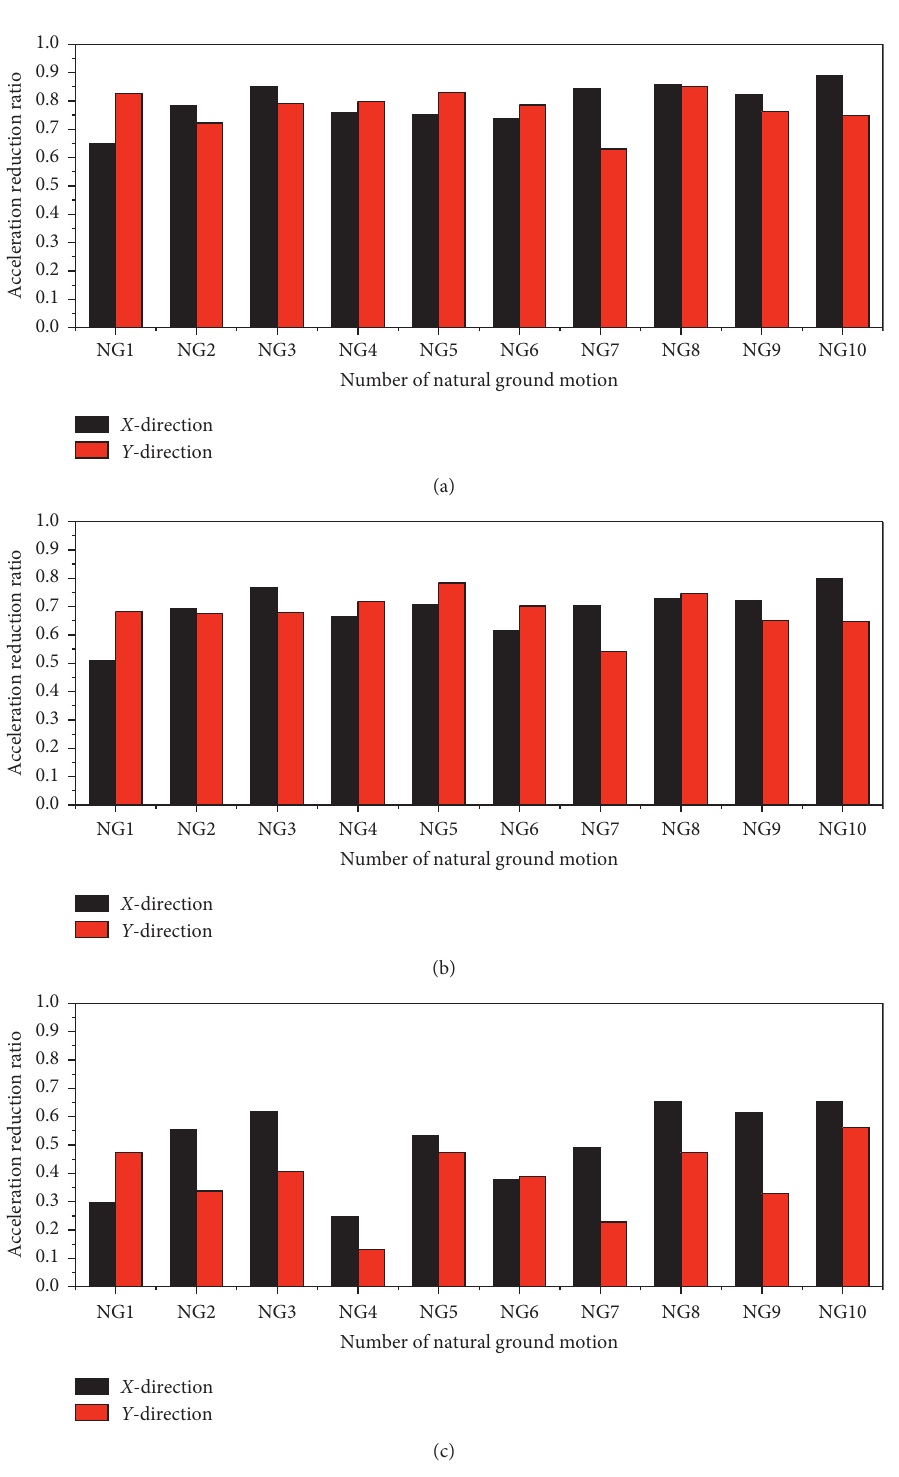
Figure 15: Acceleration reduction ratio in the horizontal directions: (a) acceleration reduction ratio of P1, (b) acceleration reduction ratio of P4, and (c) acceleration reduction ratio of